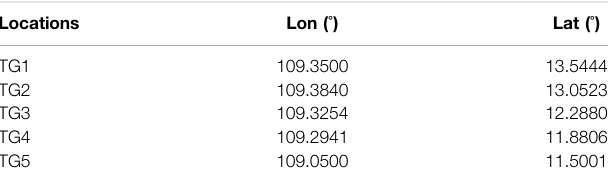
TABLE 2 | Locations of synthetic gauges.